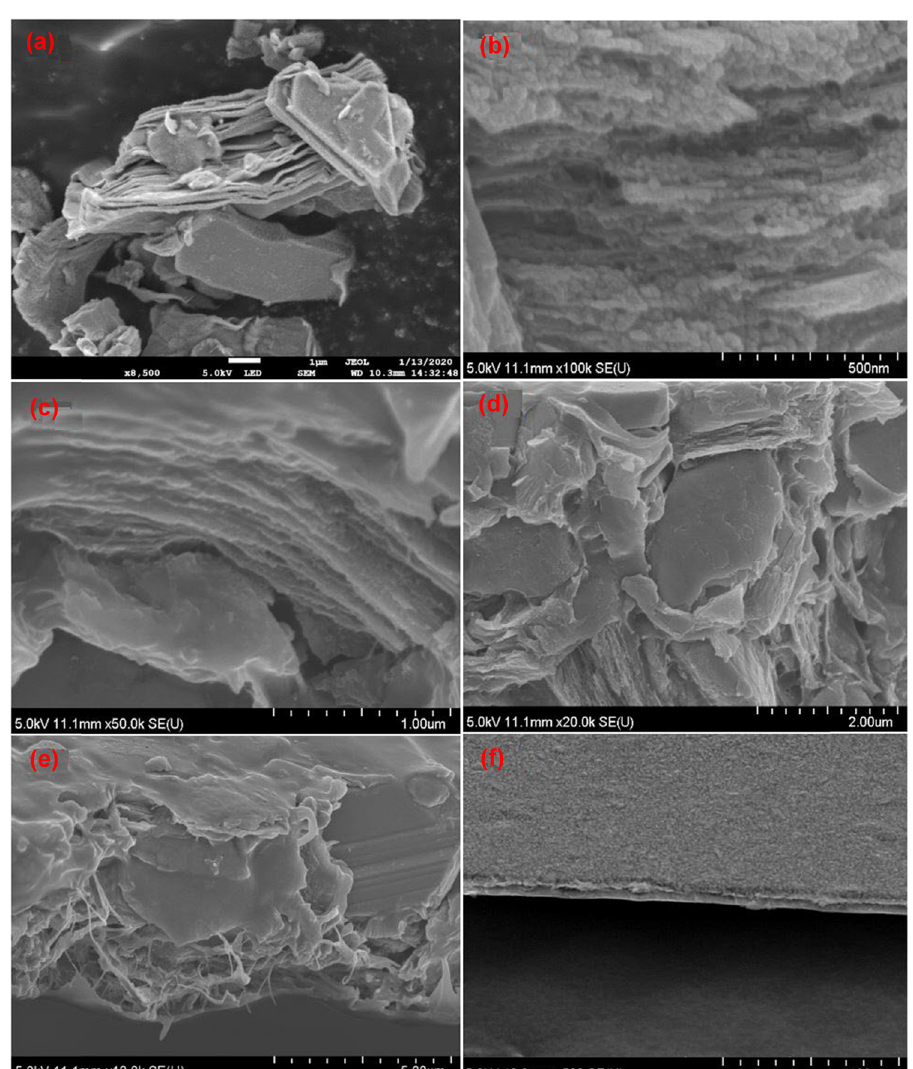
Figure 2: FESEM images of MXenes and PMMA – MXenes nanocomposite. ( a ) The formation of multilayered and delaminated pure MXenes; ( b ) cross - section of thin fi lm with 2 wt% MXenes; ( c ) cross - section of thin fi lm with 5 wt% MXenes; ( d ) thin fi lm with 8 wt% MXenes; ( e ) thin fi lm with 10 wt% MXenes; ( f ) top view of thin fi lm with 15 wt%